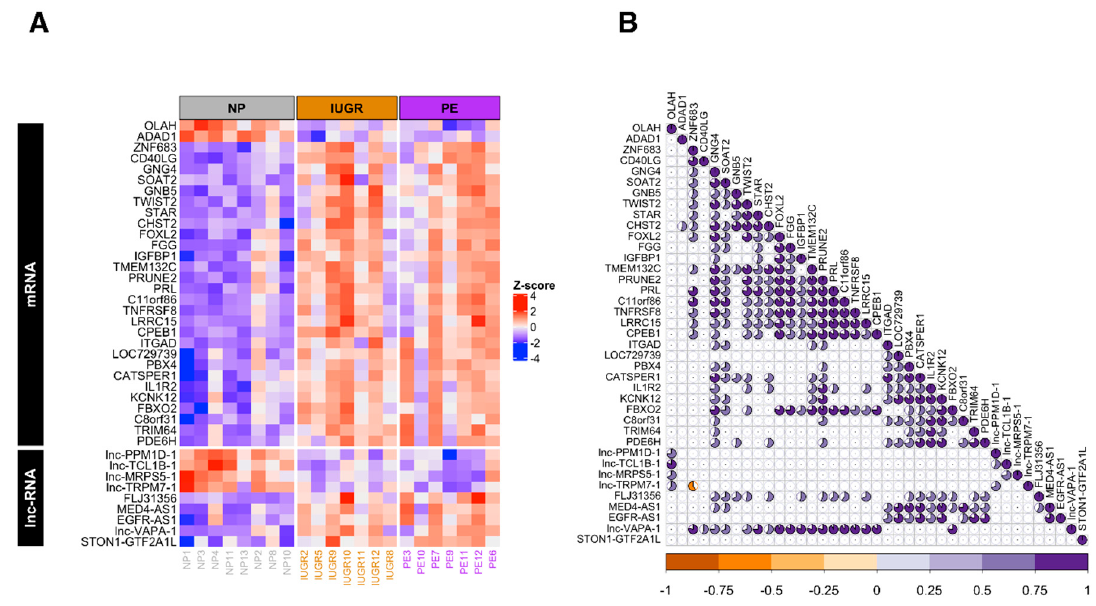
Figure 2. Selected genes differentially expressed in Intrauterine Growth Restriction and Preeclampsia compared to Normal Pregnancy. ( A ) Heatmap shows the expression levels of 39 selected genes (in rows), that are differentially expressed in IUGR and PE conditions, across samples (in columns) grouped by clinical condition. Expression levels are presented as z-score values for the purpose of visualizing expression differences across samples. The color palette indicates higher expression values in red shades and lower ones in blue shades. ( B ) Pair-wise correlations based on expression values were computed for each pair of genes in the matrix shown in A. Pearson coefficient computed for each pair of genes are presented in a triangular matrix, where genes on rows are projected diagonally and statistically significant ( p value < 0.05) Pearson coefficients of the respective comparisons against the rest of genes are shown in a pie chart manner, that is, the magnitude of Pearson correlation. Positive correlations are indicated in purple shades and negative ones in orange shades.